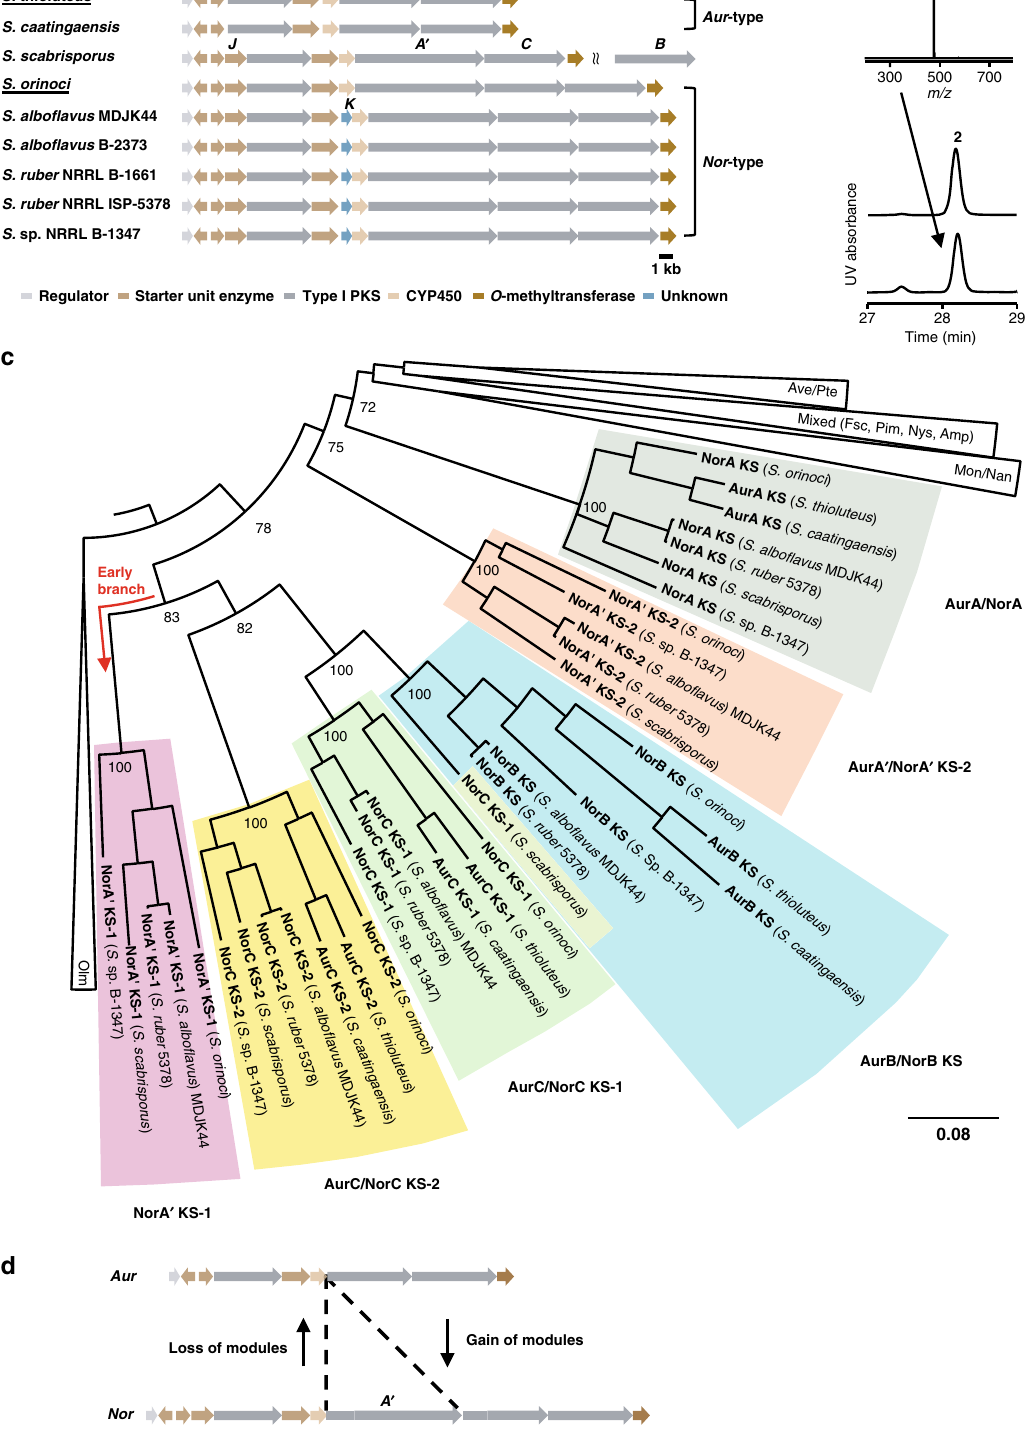
Fig. 2 Phylogenetic analysis of the aur PKS and nor PKS. a The aur -type and nor -type gene clusters. The original producers of aureothin and neoaureothin are underlined. b The HPLC pro fi le of authentic reference of neoaureothin ( 2 , middle panel), and S. scabrisporus culture (bottom panel). HR-MS spectrum of neoaureothin in top panel. UV detection is at 350 nm. c Phylogenetic tree of KS domain amino acid sequences of the aur -type and nor -type PKSs and other actinobacterial PKSs. The tree was reconstructed by Bayesian inference. Numbers at nodes indicate clade credibility values. Branch length represents the number of amino acid changes per position. Olm, oligomycin; Tyl, tylacton; Nan, nanchangmycin; Mon, monensin; Fsc, candicidin; Pim, pimaricin; Nys, nystatin; Amp, amphotericin; Ave, avermectin; Pte, polyene macrolide from S. avermitilis . Color code for KS clades corresponds with those shown in Fig. 1 d . Possible evolutionary scenarios between aur PKS and nor PKS. The source data underlying Fig. 2c are provided as a Source Data fi